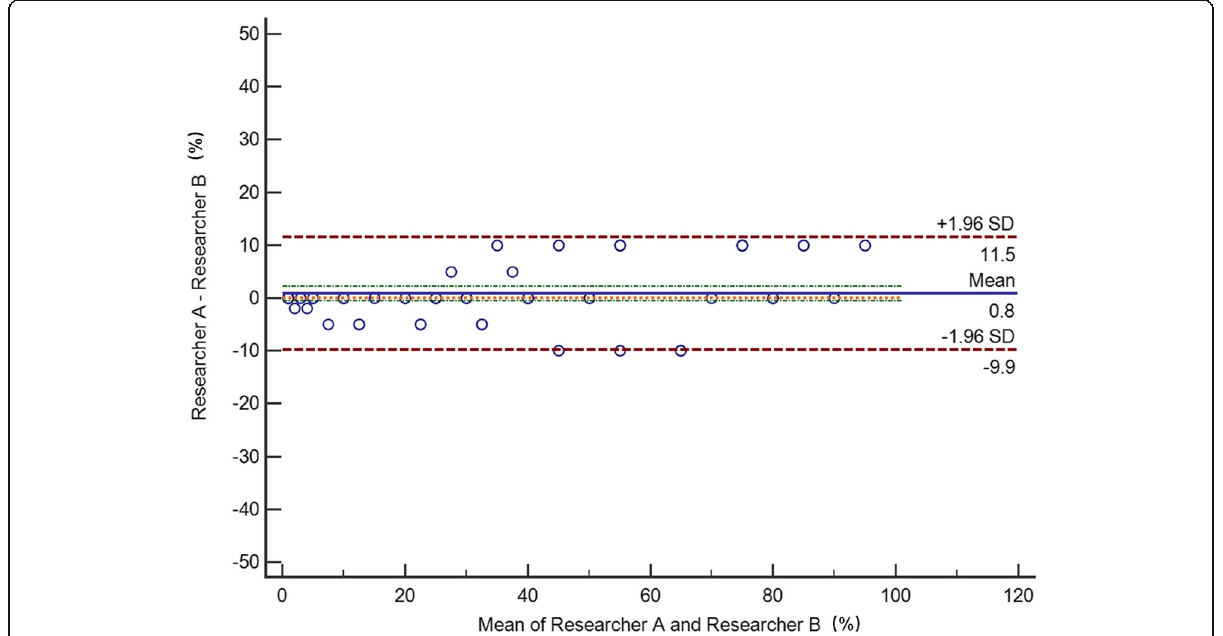
Fig. 1 Bland Altman plot for the cyclin D1 IHC score by the two pathologists (Jianying Liu and Jing